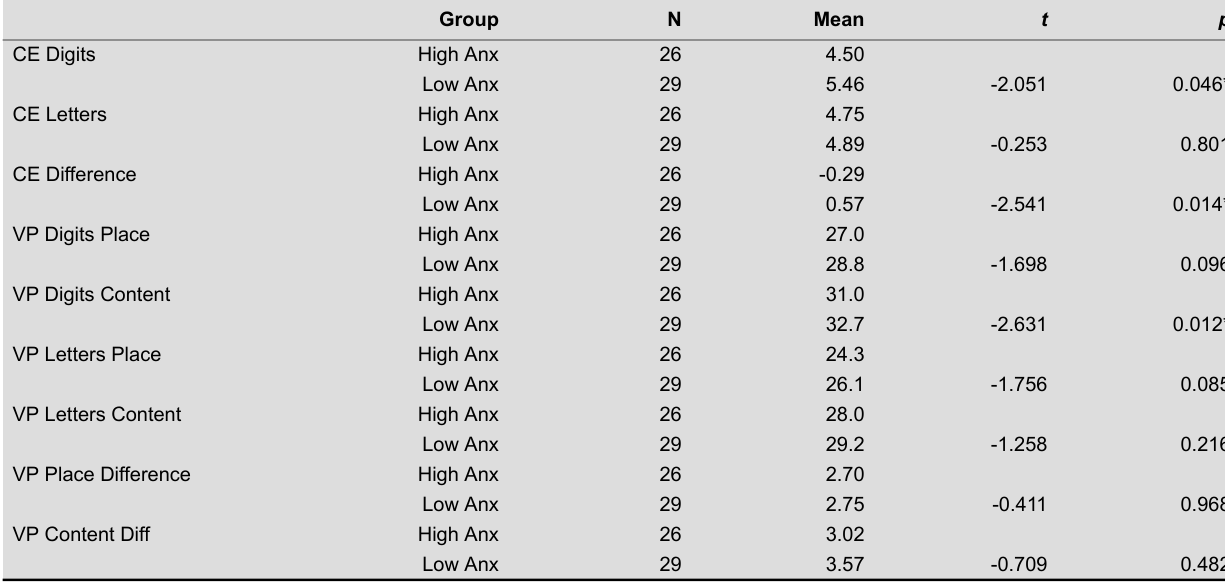
Working memory performance of the ‘high’ and ‘low’ anxiety